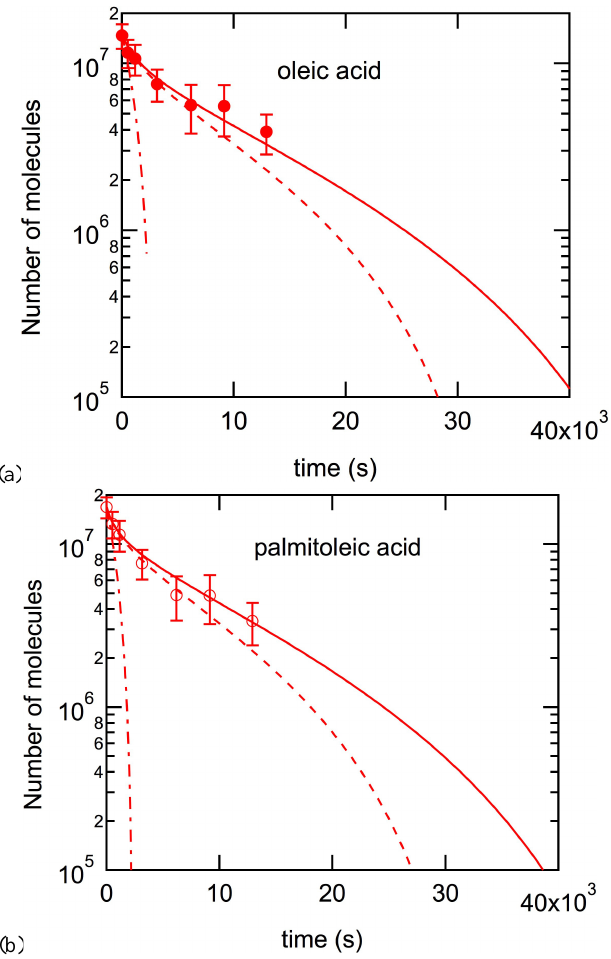
Fig. 1. Decays of numbers of molecules of (a) oleic and (b) palmi- toleic acids in a 12-component aerosol matrix as a function of time. Symbols correspond to experimental data (Huff Hartz et al., 2007). The solid line is our best model fit with solidification (diffusivity-evolution model variant). The dashed line is a model fit of the semi-solid matrix assuming constant diffusivity (constant- diffusivity variant). The dot-dashed line 1 represents a fit using a resistor-model formulation